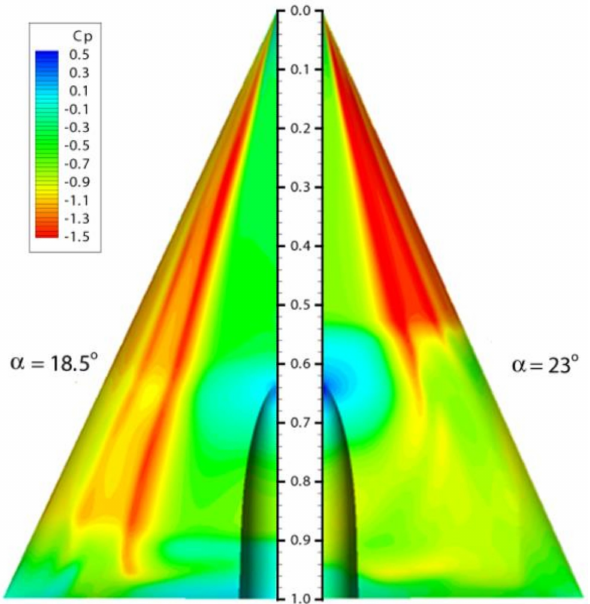
Figure 7. Pressure coefficients distribution contours by CFD herein on the upper surface of delta wing, Ma = 0.85, Re = 6 × 10 6